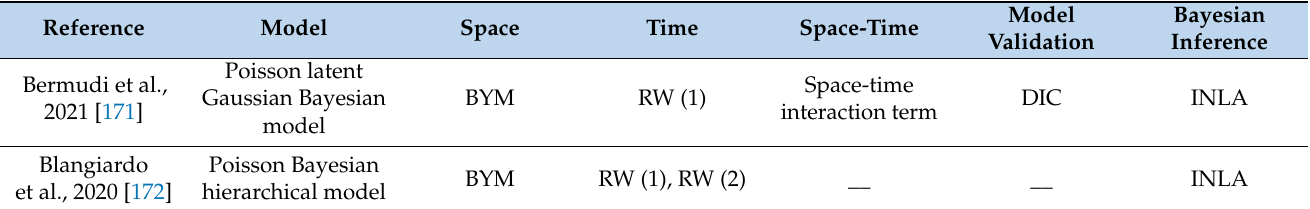
Table 2. Structure of the Bayesian statistical